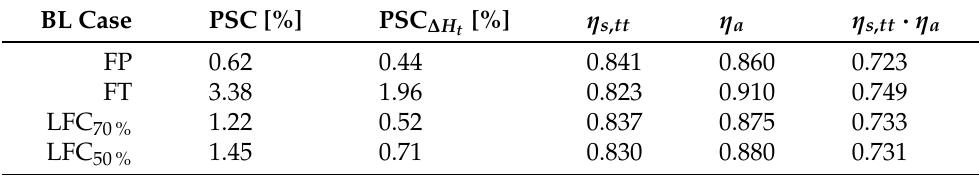
Figure 12. PSC (o) and PSC ∆ H (+) over the thrust requirement for varying boundary layer conditions t at A = A ref . Table 2. PSC, PSC ∆ H , and efficiencies for varying boundary layer cases at reference t